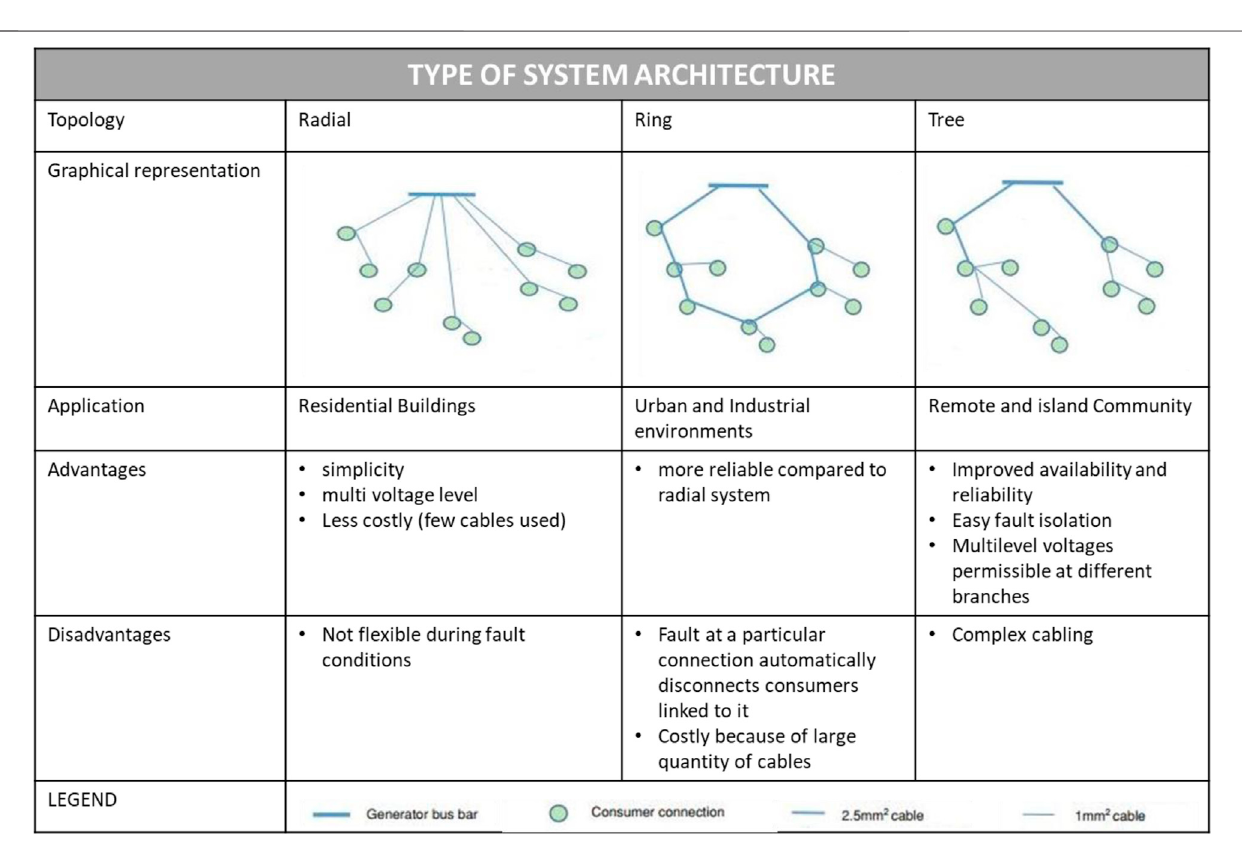
Frontiers in Energy Research |